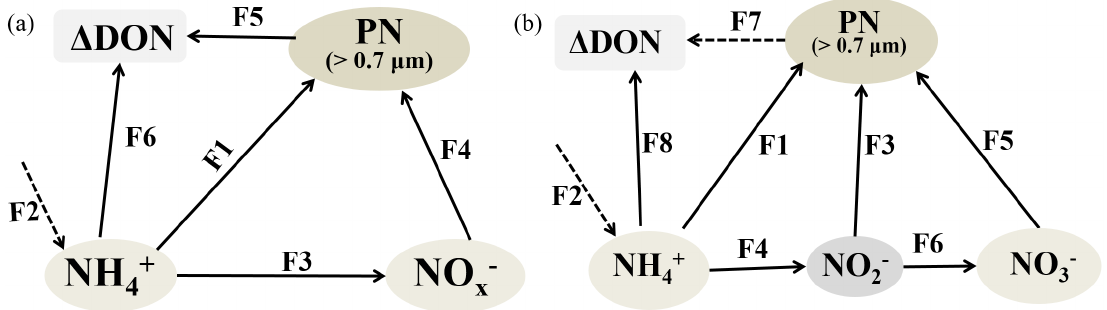
Figure 1. Model schemes with the most fundamental nitrogen transformation processes in (a) low- and (b) high-nutrient aquatic environ- ments. Arrows represent the transfer flux/rate from the reactant to product pool. The structure and inter-exchanges in the high-nutrient case (b) are the same as in (a) , except that NO − x is divided into NO −